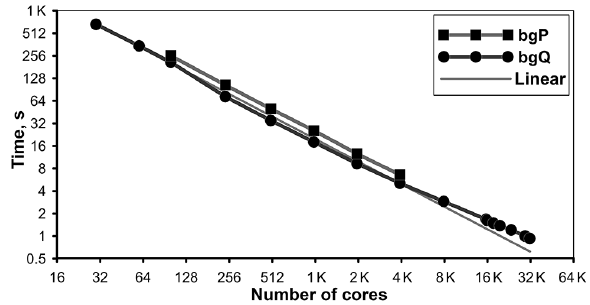
Figure 9. Wall-clock time of the 0.1 ◦ resolution INMIO WOM (governed by the CMF2.0) 10 model steps vs. model communi- cator size on the BlueGene/P supercomputer (Moscow State Uni- versity) and BlueGene/Q supercomputer (IBM Research Center Thomas J.